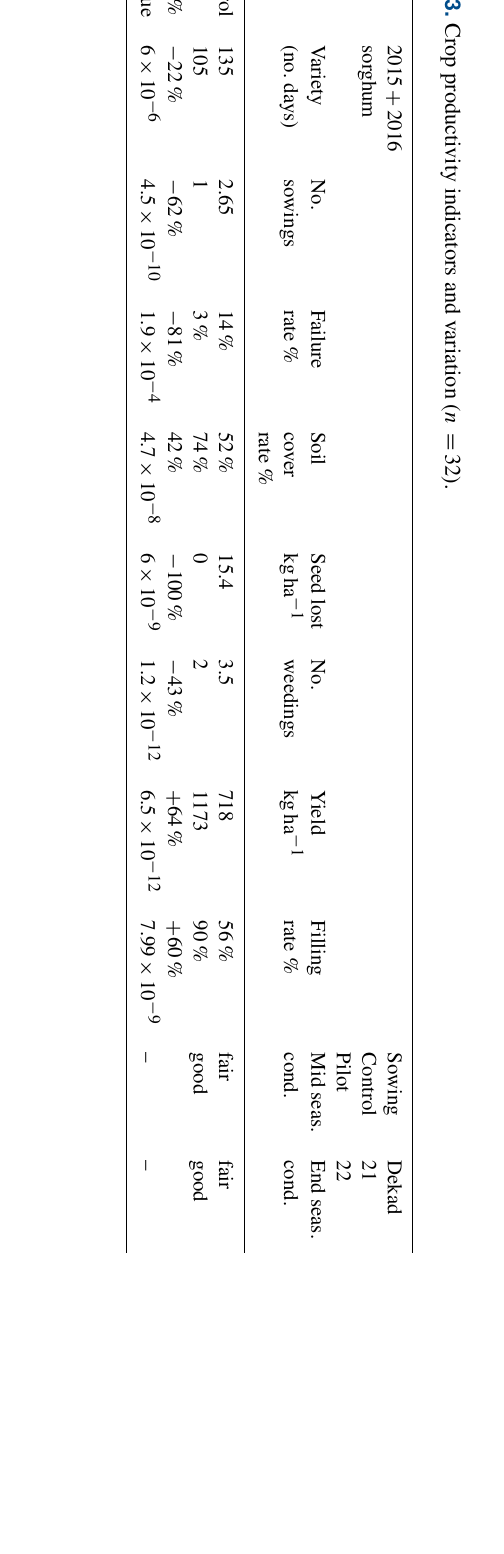
Table 4. Average agro-economic performance on 2015 and 2016